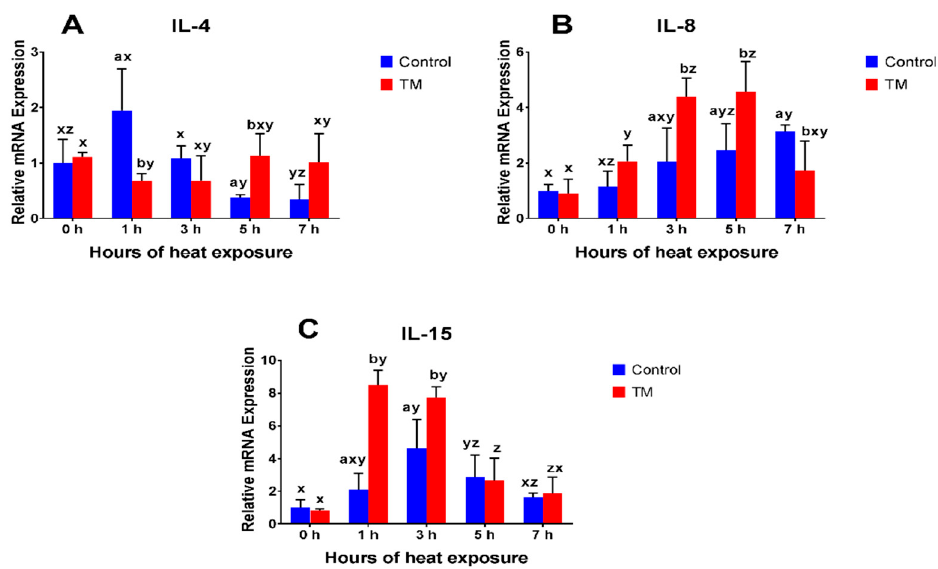
Figure 3. Impact of AHS at 40 °C for for 1, 3, 5, and 7 h on post-hatch day 28 on the splenic mRNA levels of ( A ) IL-4, ( B ) IL-8, and ( C ) IL-15 in broiler chickens subjected to TM (n = 5). The values in the chart indicate folds of mRNA levels compared to the control groups at 0 h before AHS. a,b Within the same point of time, values ± SD of TM and control groups with different superscripts are significantly different ( P < 0.05). x–z Within the same treatment group and between different points of time, values ± SD with different superscripts are significantly different ( P < 0.05).